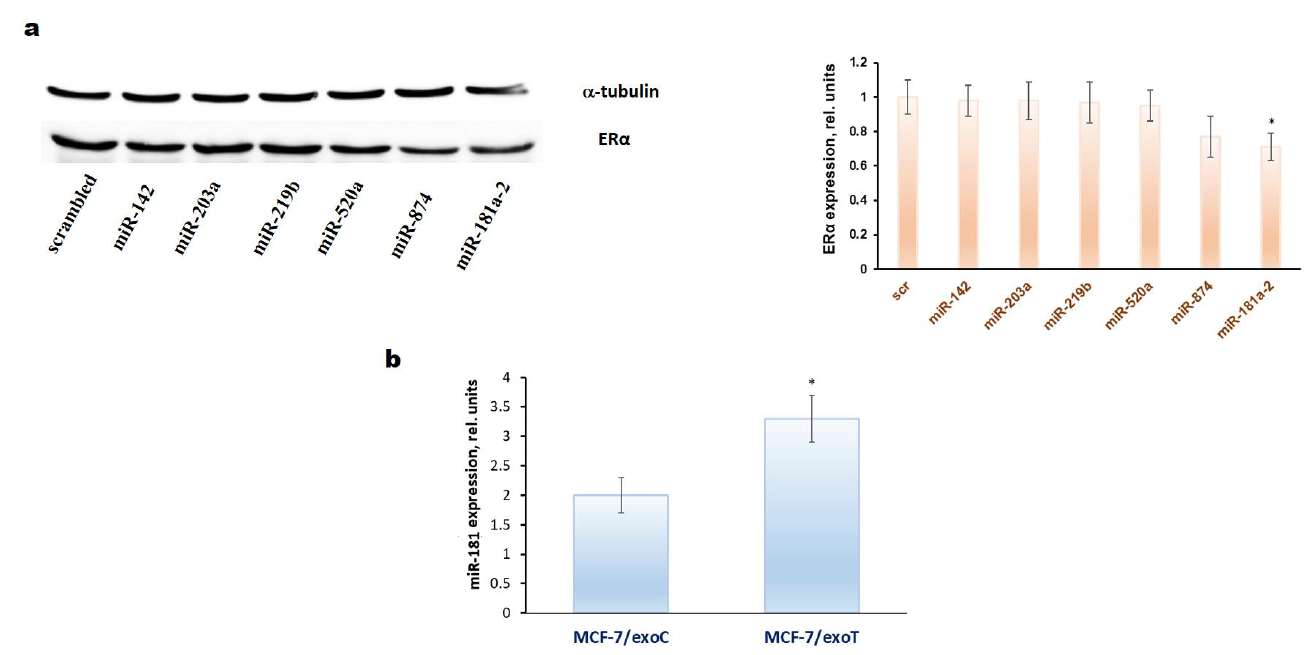
Figure 1. ( a ) Influence of miRNAs transfection on the ER α expression in the MCF7 cells. The single transfection by the miRNAs mimetics was performed as described in Methods. Twenty-four hours after transfection the Western blot analysis of ER α expression in the cell lysates was performed. Protein loading was controlled by membrane hybridization with α -tubulin antibodies. Densitometry for immunoblotting data (right diagram) was carried out using ImageJ software (Wayne Rasband, NIH) with the recommendations from the work [83]; * p < 0.05 versus scrambled (scr); ( b ) quantification of endogenous miR-181a expression (vertical axis) in the exosome-treated MCF-7 cells by qRT-PCR. The MCF-7 cells were cultured in the presence of the exosomes isolated from MCF-7 (exoC) and MCF-7/T (exoT) cells for 30 days with following cell cultivation within the next 30 days after exosomes withdrawal. Three separate measurements were performed for each sample. The expression of RNU6B was used as an internal control. Error bars indicate standard deviation; * p < 0.05 versus MCF-7 cells treated with exoC.